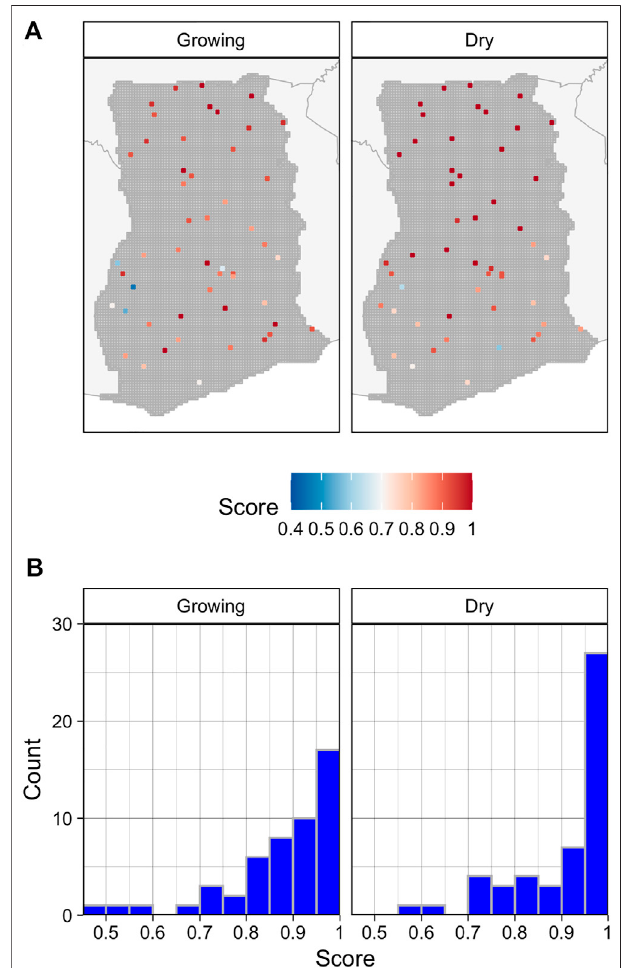
FIGURE 3 | The location and quality scores of 100 randomly selected tiles (A) for the growing and off-growing season, and the corresponding distributions of the quality for each season (B)